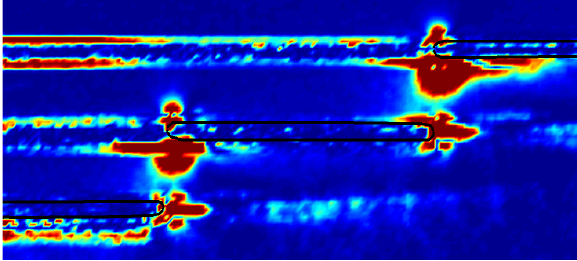
Fig. 8. Comparison of x component of velocity at point 2 Fig. 12. Measured power spectral density of y -component of velocity